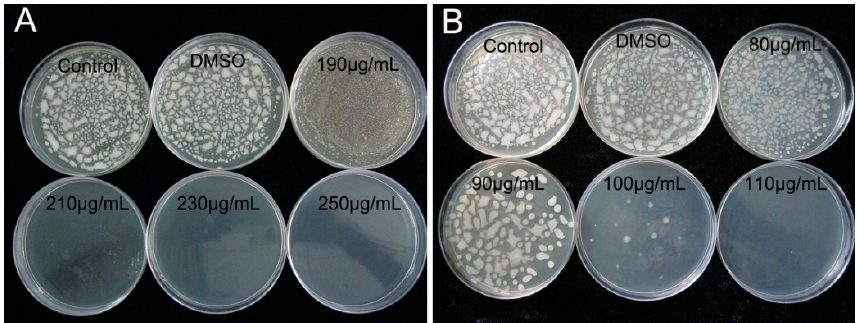
Figure 2. The colony growth of R. solanacearum treated with: ( A ) resveratrol at concentrations ranging from 190 to 250 μ g/mL; and ( B ) coumarin at concentrations ranging from 80 to 110 μ g/mL.